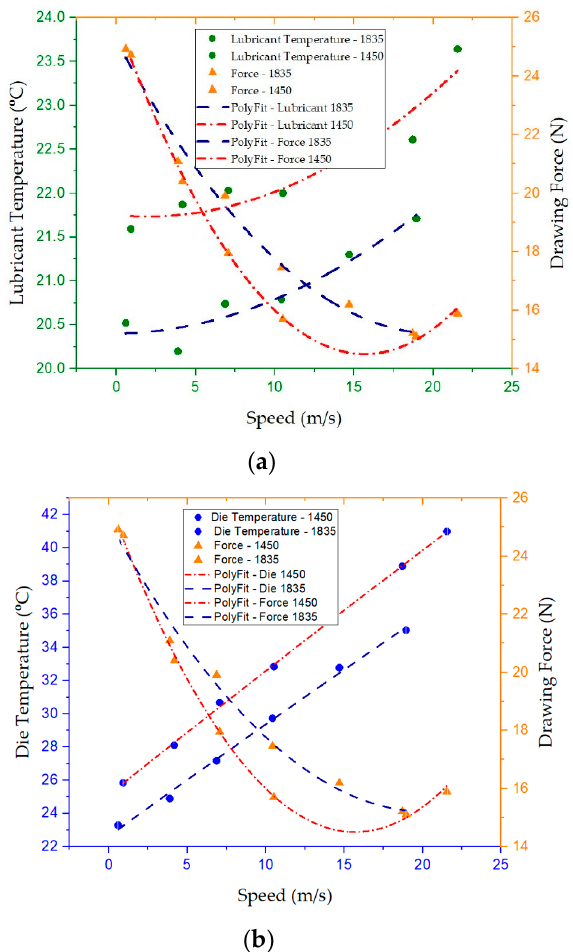
Figure 4. Temperatures of lubricant ( a ) and die ( b ) and drawing force as functions of drawing speed for the dies 1450 and 1835.